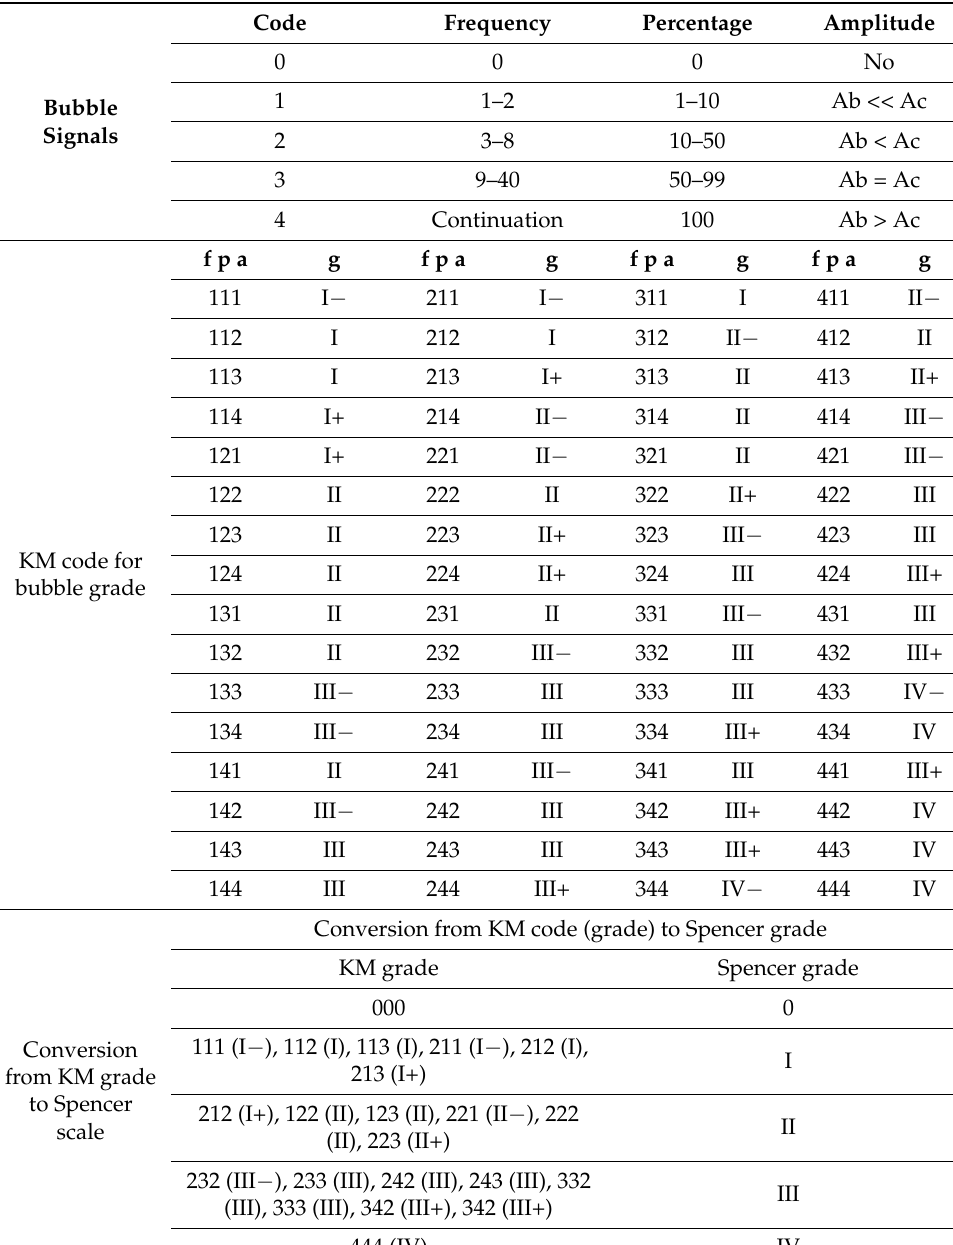
Table 2. Bubble signals, KM code for bubble grade and bubble grade